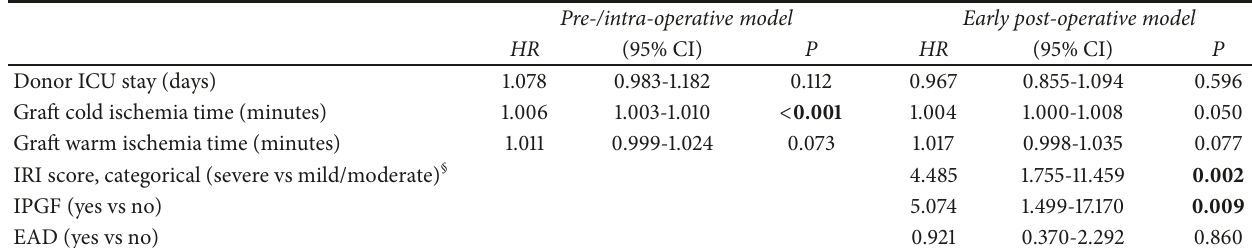
Table 4: Multivariable Cox regression models for overall graft loss in recipients with HCV positive liver